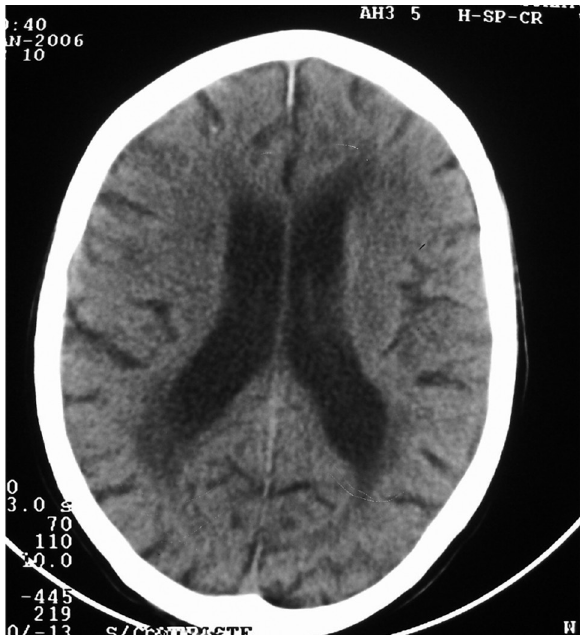
Figure 1. CT showing leukoaraiosis (periventricular hypodensity) suggestive of Binswanger’s